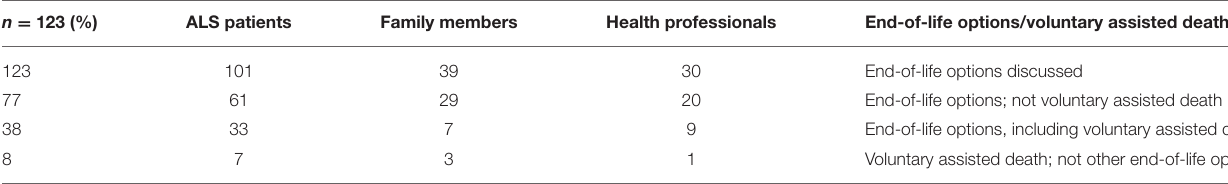
TABLE 4 | Views represented in articles discussing end-of-life options and/or voluntary assisted death. n = 123